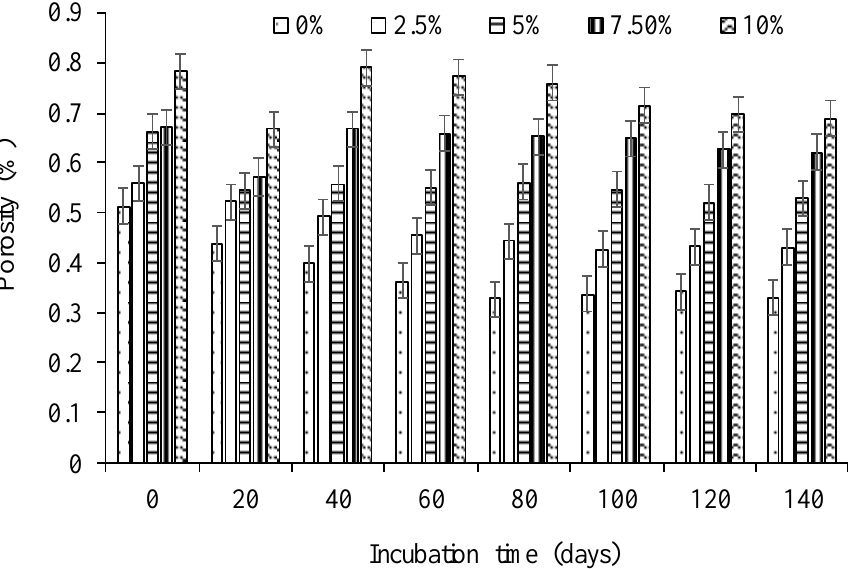
Figure 6 . Changes in porosity during incubation of a Hutton soil amended with different biochar rates. Error bars indicate SD.